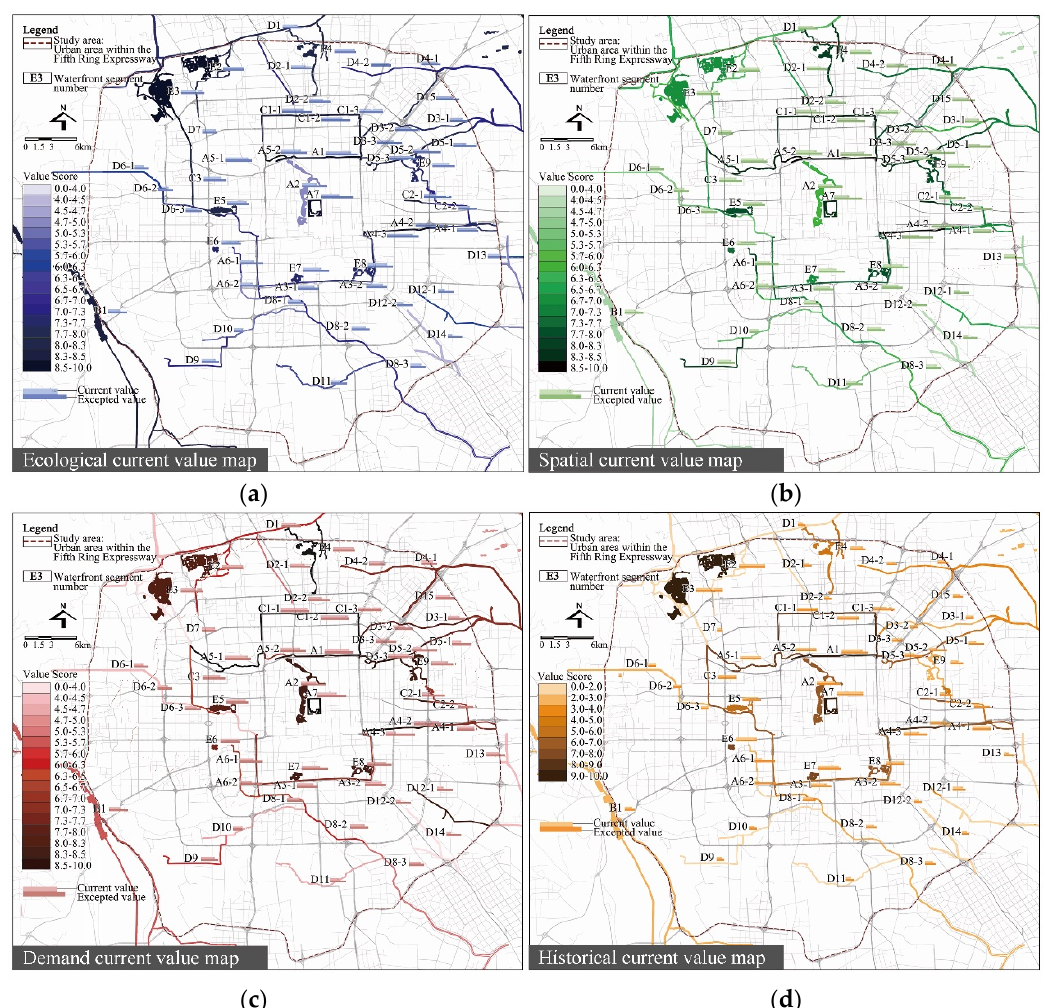
Figure 7. Maps of the values of four urban layer subsystems of Beijing’s waterfront: ( a ) the ecological current value map, ( b ) the spatial current value map, ( c ) the demand current value map, ( d ) the historical current value map.